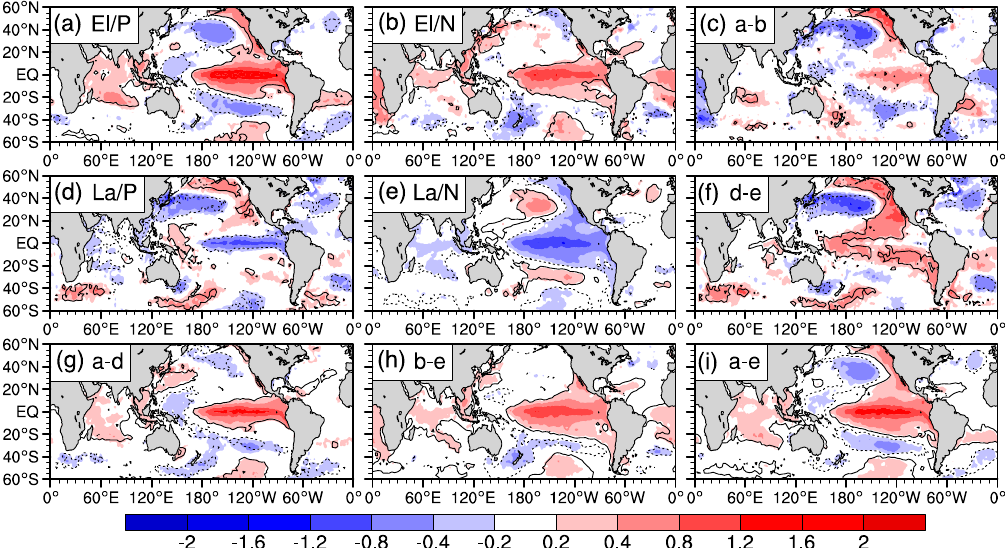
Figure 2. Composite SST anomalies during El Niño winters when the PDO is in its ( a ) positive and ( b ) negative phases. ( c ) The di ff erence between ( a ) and ( b ). ( d – f ) As in ( a – c ) but for La Niña winters. ( g , h ) The half di ff erence between El Niño and La Niña during the positive / negative phases of the PDO. ( i ) The half di ff erence between ( a ) and ( e ). The black contours mark the SST anomalies at the 90% confidence level.